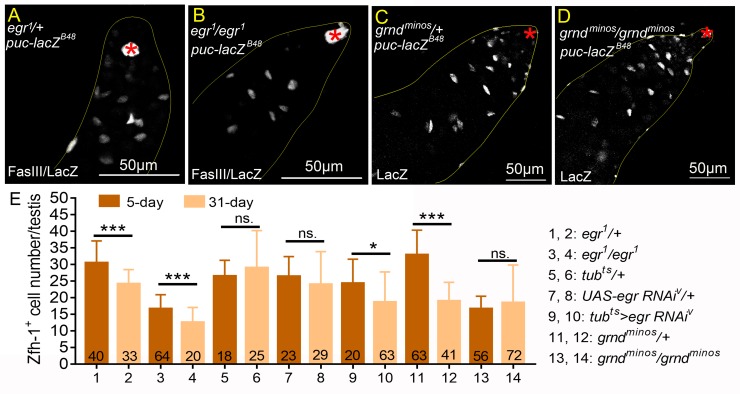
Egr-Grnd is not essential for endogenous JNK signaling activation in cyst cells.(A-D) Testes from unmated 1w-old puc-lacZB48 males immunostained for β-Galactosidase, co-stained for FasIII to mark hubs (asterisks). LacZ expression was comparable between heterozygous controls and the homozygous mutants for egr1 (A and B) and grndminos (C and D). (E) Numbers of Zfh-1-positive cells in the testes from unmated 5- and 31-day-old males. Numbers of testes scored are shown at the bottom of each column. Statistic significances were calculated with student t test in E, and ns: p>0.05, *p<0.05, ***p<0.001. Unmated males (30 vs. 0) were examined in all experiments.